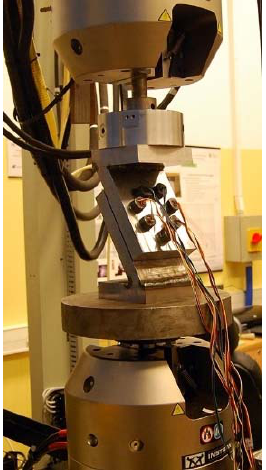
Figure 4. The main research stand.